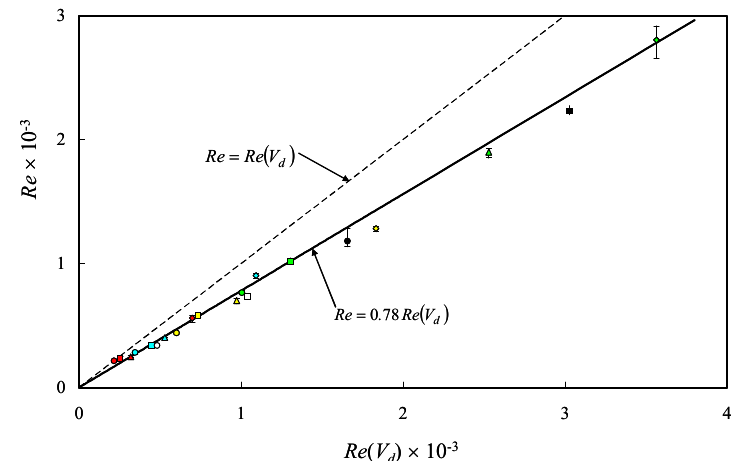
Fig. 11 Reynolds number Re versus the Reynolds number Re ( V d ) based on V d , for λ = 0.3, AR = 10, C = 7.2 × 10 1 − 1.6 × 10 3 and I * = 0.75 −